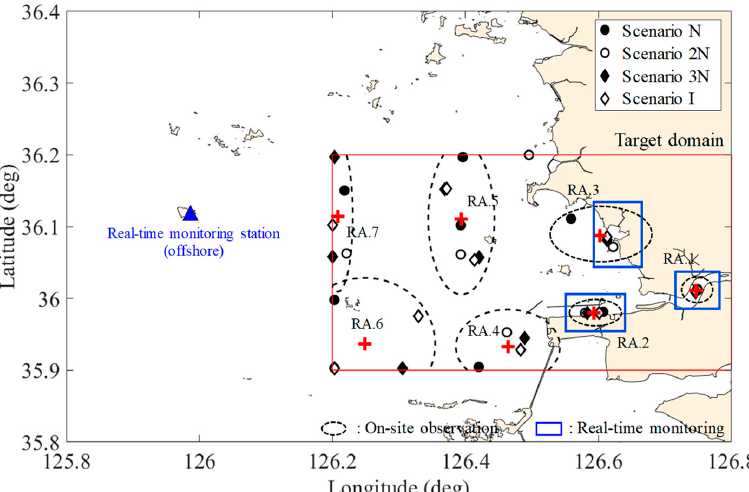
Figure 8. The selected points of the on-site monitoring ( red ‘ + ’ ) and the installable area of real-time monitoring station ( blue rectangles ) in accordance with each scenario. The series of black dotted ellipses indicate maximum distances from the reference points ( red ‘+’ ) corresponding to weight 1, and the blue rectangular regions are the installation area of the real-time monitoring station, which represent the temporal distribution of the local characteristics well. The blue triangle located in the outside of the target domain is the reference point of the offshore real-time monitoring station. The abbreviation “RA” imply the representative area.